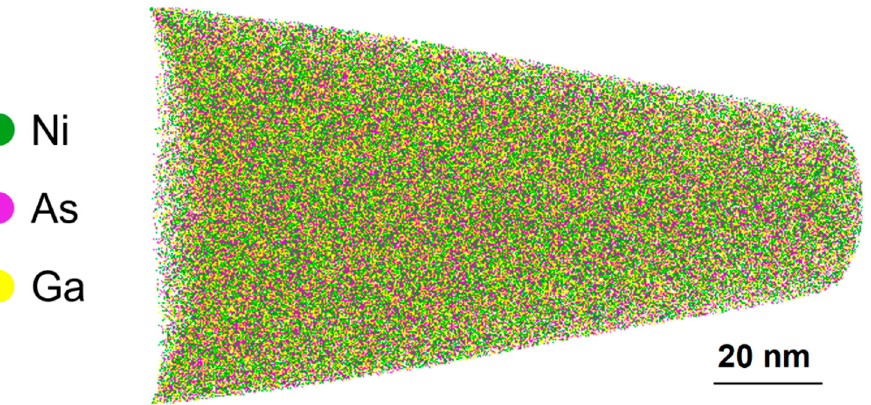
Figure 4. APT microscopy performed on the 500 nm Ni/GaAs after an isothermal annealing at 200 °C, Cross-sectional view of a 10 nm-thick slice (xz plane) extracted from 3D volume showing the distribution of Ni, Ga, and As atoms (green, yellow, and pink dots, respectively).